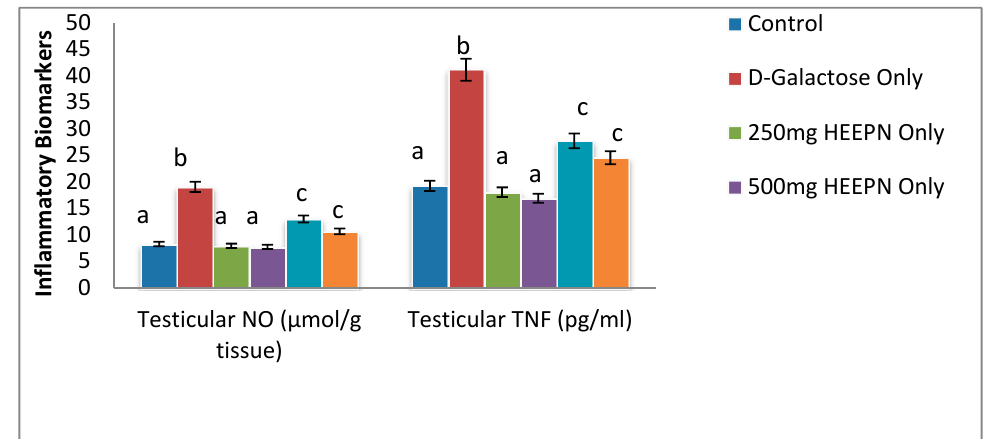
Figure 5. Effect of graded doses of HELEPN on inflammatory biomarkers. Values are means of five replicates ± SEM. Bars carrying different superscripts (a–c) are significantly different at p < 0.05.